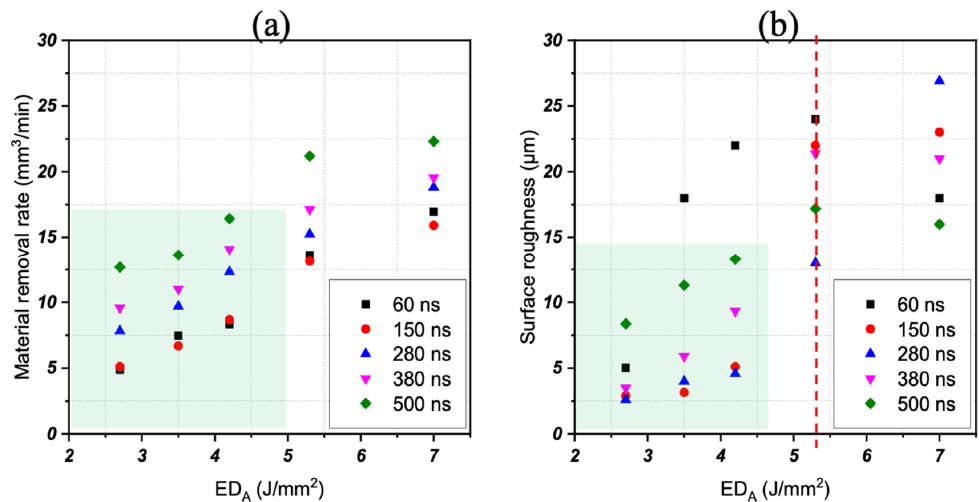
Figure 10. ( a ) MRR and ( b ) S a as a function of area energy dose ( ED A ) for di ff erent pulse durations. The highlighted region in panel ( a ) excludes 60 ns ( > 2.7 J / mm 2 ), and the dashed line represents a critical ED A beyond which the surface is blackened and surface quality deteriorates significantly.